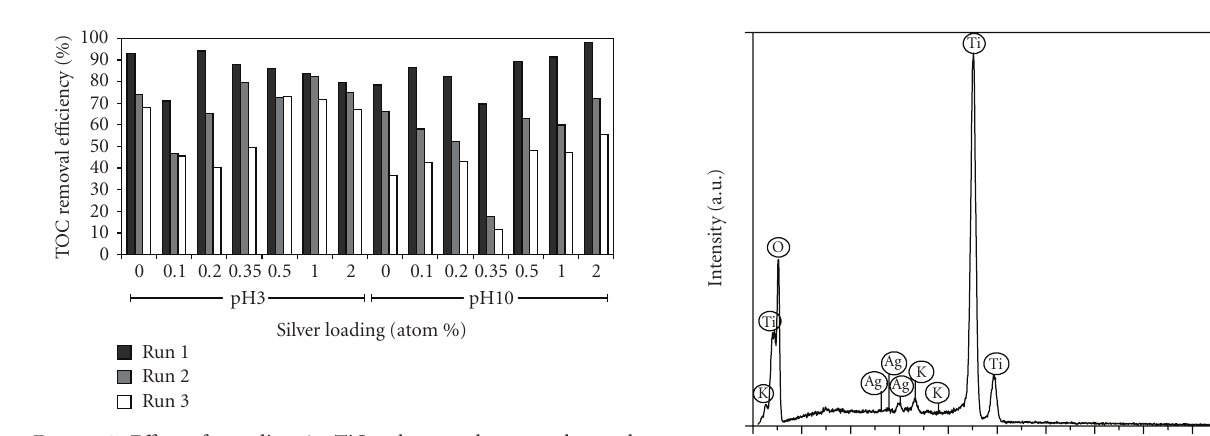
Figure 9: E ff ect of recycling Ag-TiO 2 photocatalysts on observed TOC removal at pH 3 and pH 10 (1st run (cid:2) , 2nd run , and 3rd run (cid:3) ), degradation of 1 mM DCA without any extra addition of chloride ions or washing technique performed. The light intensity at pH 3 was I ≈ 3 . 39 × 10 − 2 Einstein L − 1 h − 1 and at pH 10 was I ≈ 3 . 74 × 10 − 2 Einstein L − 1 h − 1 .